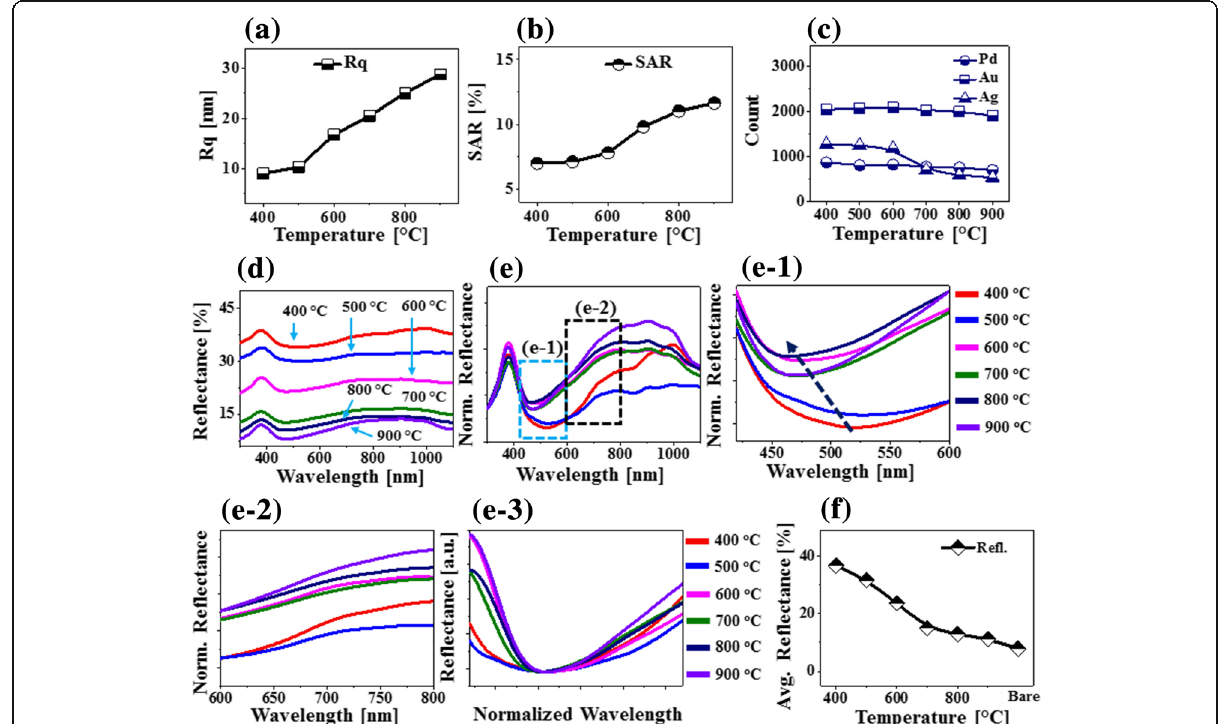
Fig. 5 Morphological, elemental and optical analysis of corresponging PdAuAg nanostructures (multi-layers). a , b Plots of Rq and SAR. c Plots of Pd, Au, and Ag EDS counts. d Reflectance spectra. e Summary plot of average reflectance. f Normalized reflectance spectra at 300 nm. f-1 – f-2 Magnified regions boxed in f . f-3 Normalized reflectance spectra to show the absorption dip width